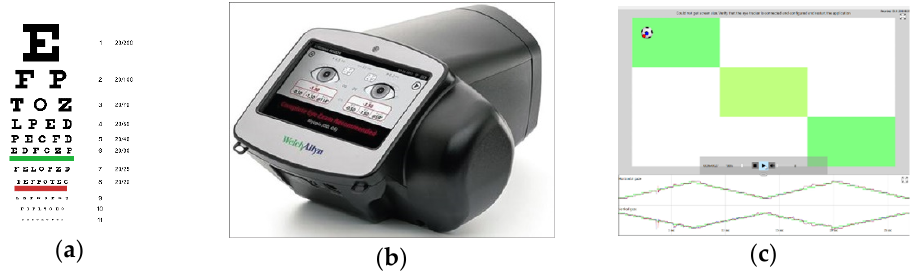
Figure 2. Different tools and computer software programs supporting different phases in a vision screening: ( a ) Snellen chart used for traditional vision screening (image downloaded from https://en.wikipedia.org/wiki/Snellen_chart#/media/File:Snellen_chart.svg, accessed date 15 October 2021); ( b ) Welsch Allyn Spot Vision Screener is an instrumental device used for measuring refractive error (image downloaded from https://www.gocheckkids.com/welch-allyn-spot-vision-screener, accessed date 15 October 2021); ( c ) C&Look is an eye-tracking computer software for screening oculomotor problems.